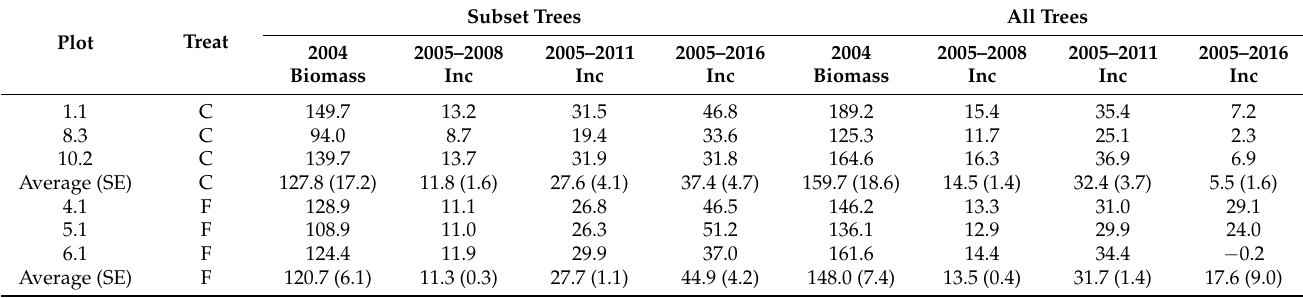
Table 3. Plot level stem biomass (Mg ha − 1 ), cumulative biomass increments, and control (C) or fertilized (F) treatment averages for the subset trees in the plots, as well as all trees. Subset Plot Treat